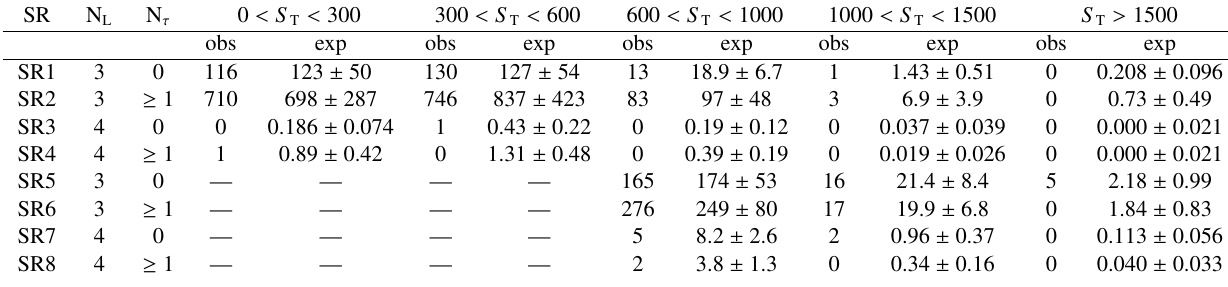
Table 2. Observed yields for three- and four- lepton events from 19.5 fb − 1 recorded in 2012. The channels are split by the total number of leptons (N L ), the number of τ h candidates (N τ ), and the S T . Expected yields are the sum of simulation and estimates of backgrounds from data in each channel. SR1–SR4 require a b-tagged jet and veto events containing Z bosons. SR5–SR8 contain events that either contain a Z boson or have no b-tagged jet. The channels are mutually exclusive. The uncertainties include statistical and systematic uncertainties. The S T values are given inGeV.